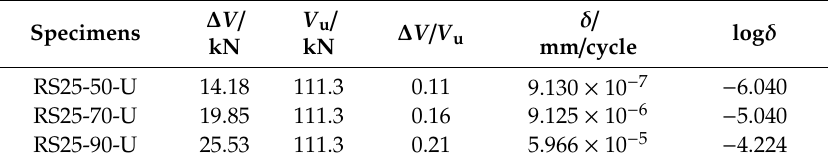
Figure 20. Growth rate of the maximum dynamic relative slip. Table 7. Experimental results of average growth